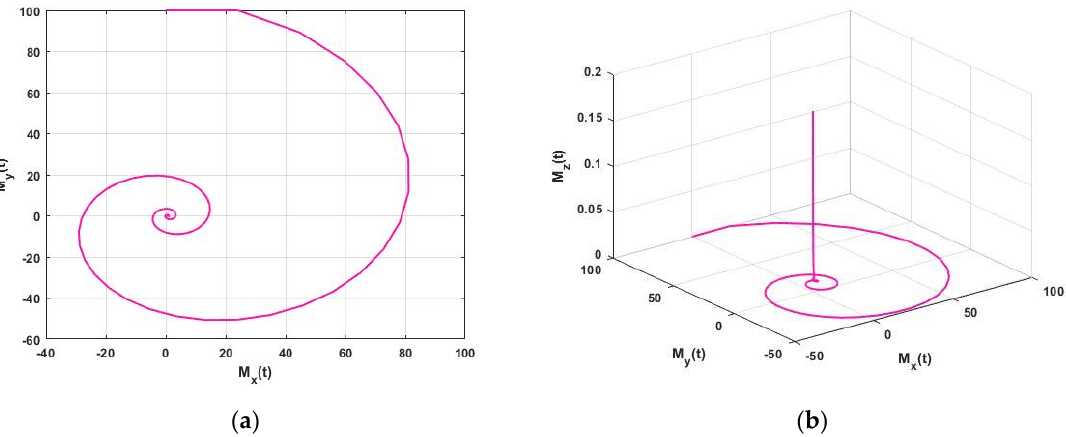
Figure 5. Approximate solution ( a ) 2D Plot and ( b ) 3D Plot of the FNMRF system for 𝛼 (cid:3404) 𝛽 (cid:3404) 𝜂 (cid:3404)